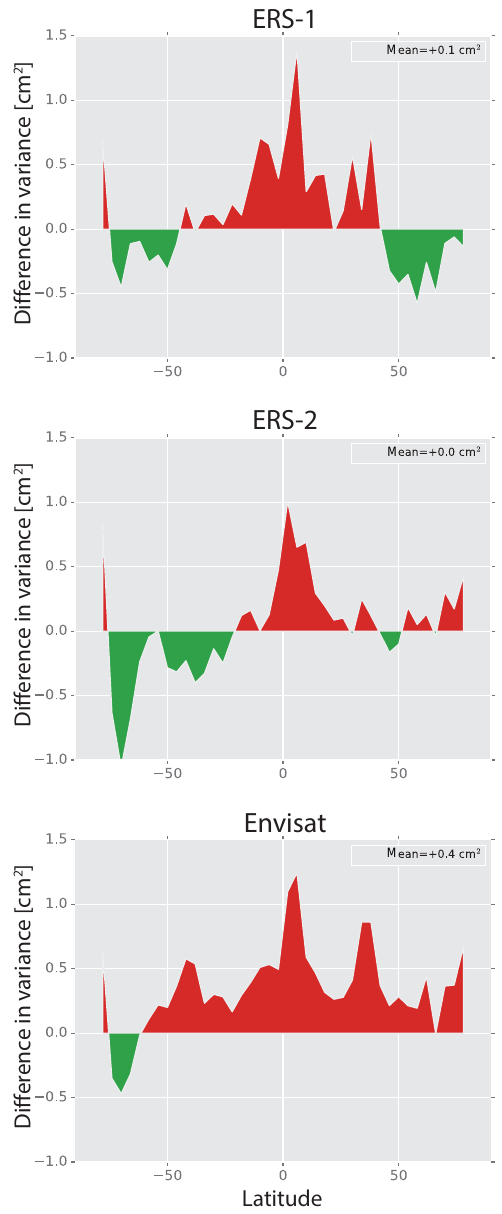
Figure 7. Zonally averaged patterns of improvement (green) and de- terioration (red) of our retrieval over the operational ESA